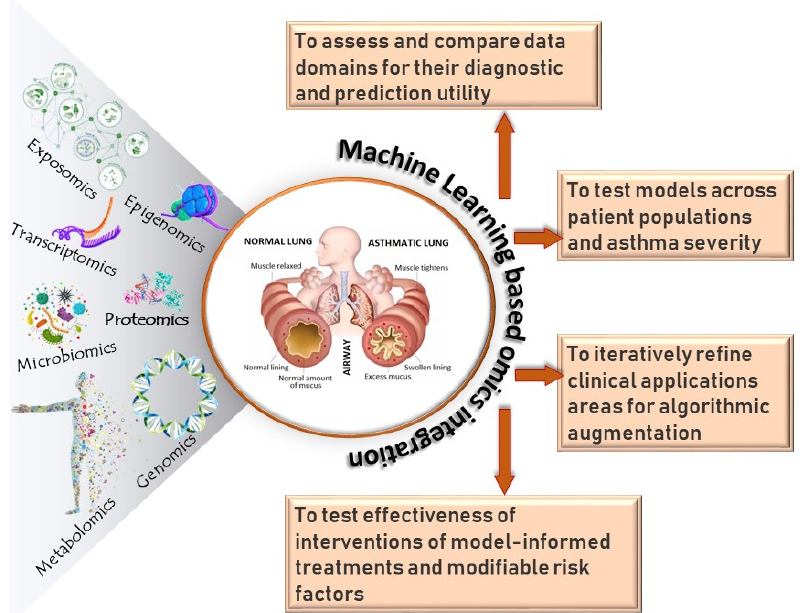
Figure 3. Overview of multi-omics integration in asthma. Mutli-omics integration could enhance our understanding of asthma including asthma development, asthma subtypes, and clinical symptoms, and it could lead to the development of novel intervention approaches and drug targets for asthma control and prevention.